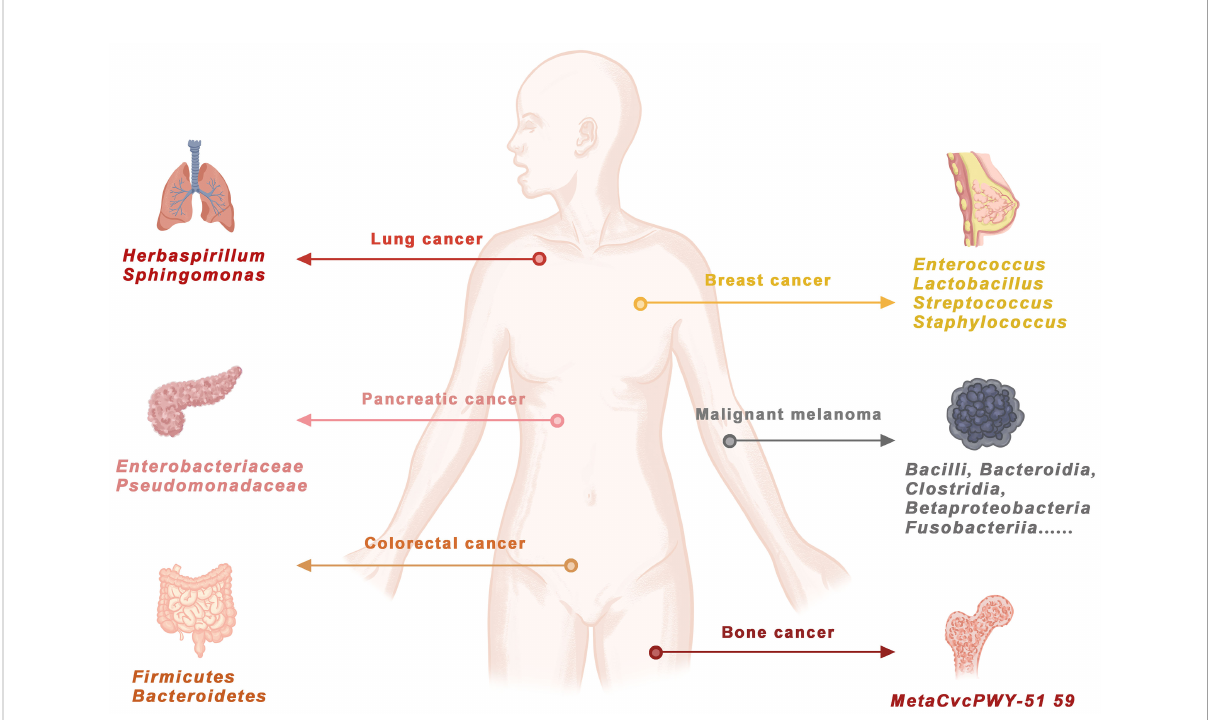
FIGURE 1 Bacterial DNA exists in human cancers.Through genome sequencing, PCR ampli fi cation, 16S RNA detection and KEGG/TCGA database comparison, bacterial DNA was con fi rmed in lung cancer, pancreatic cancer, breast cancer, malignant melanoma, colorectal cancer and bone cancer. DOI: